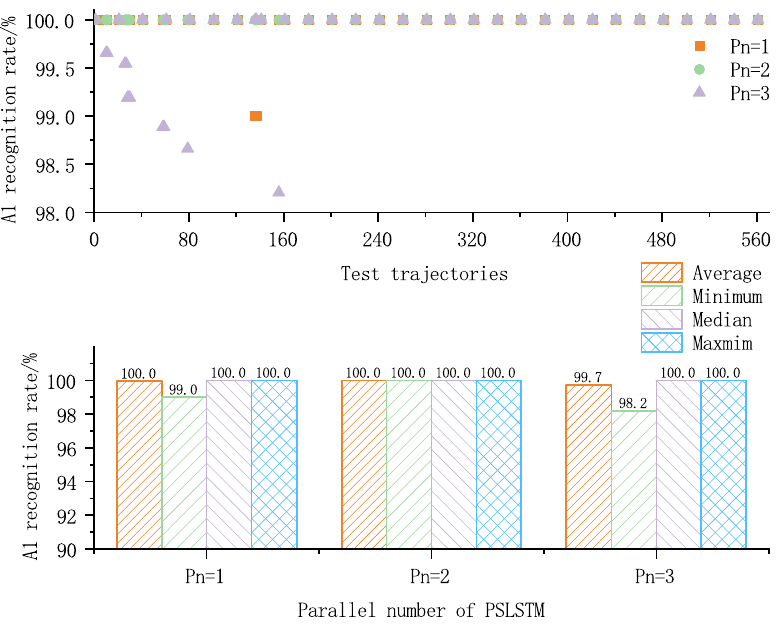
Figure 7. A1 recognition